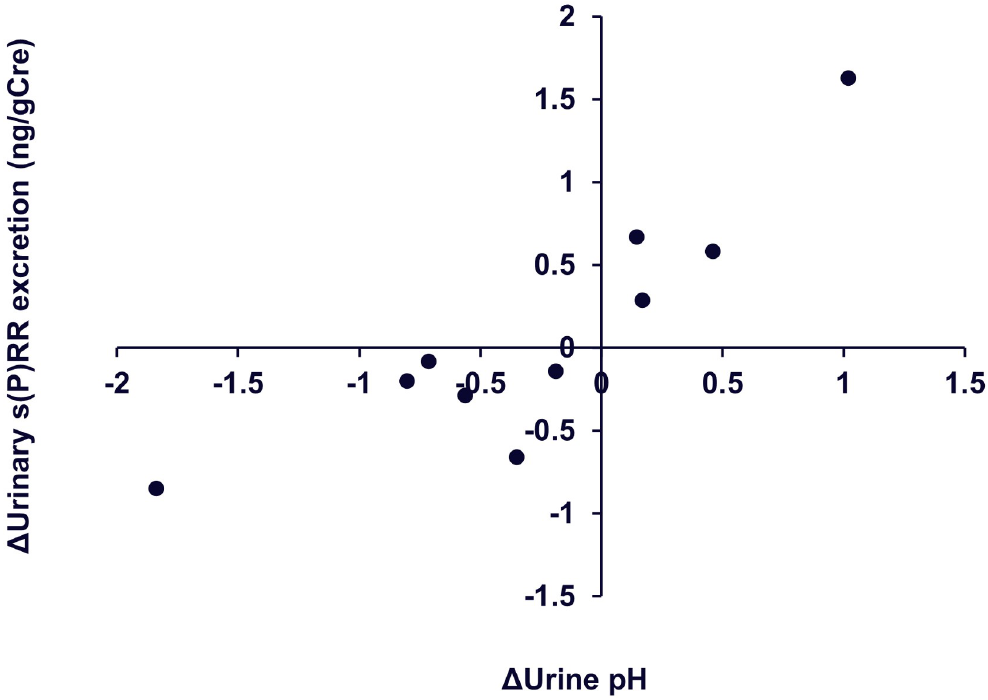
Fig 7. Scattergrams showing relationship between changes ( Δ ) in urine pH and urinary s(P)RR excretion by vitamin C treatment. Closed circles, each with 10 volunteers (r = 0.878, P < 0.05), using Spearman’s rank correlation coefficient. s(P) RR, soluble (pro)renin